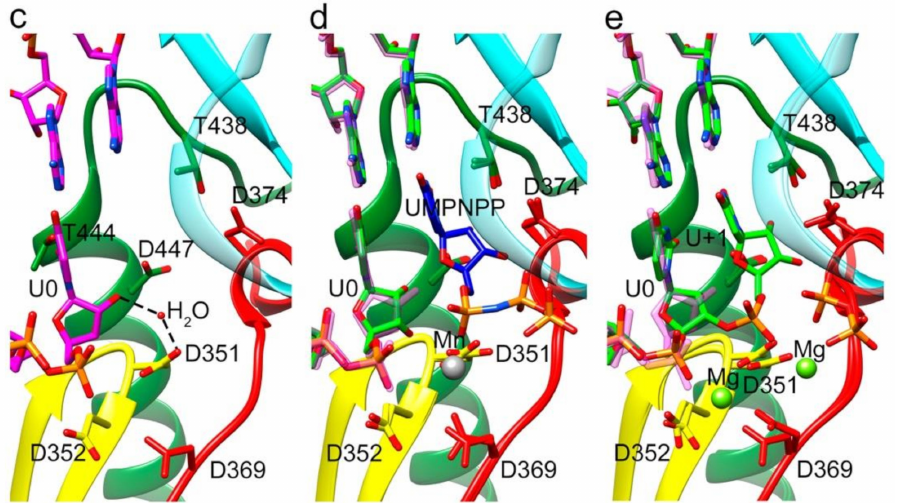
Figure 4. Overall structure of the TaV RdRP in complex with RNA and the incoming nucleoside analogue uridine-5’-[( α , β )-imido]triphosphate (UMPNPP). ( a ) Side view of the overall structure of the ∆ 10-TaV pol ∆ 607-624/5 (cid:48) CAAAAUUU3 (cid:48) /UMPNPP complex enzyme (grey) with the conserved motifs and the bound RNA template/primer colored as in Figure 1. The substrate analogue is shown as sticks, colored according to atom type (C blue). ( b ) Close up view of the interactions involved in substrate analogue recognition. The side chains of residues D374 (motif A) and T438 and D447 (motif B) that participate in UMPNPP 2 (cid:48) -OH recognition are shown as sticks and explicitly labeled. One Mn 2+ ion was found in the active site interacting with D351 (motif C), D369 (motif A) and the phosphate 1 moiety of the substrate. ( c ) Close up view of the active site region (same orientation as in B), in the structure of the TaV pol ∆ 607-624/5 (cid:48) CAAAAUUU3 (cid:48) complex obtained in the absence of incoming nucleotides. The polymerase molecule is shown as green ribbons with the key active site chain depicted as sticks. ( d ) Superimpositions of the TaV pol ∆ 607-624/5 (cid:48) CAAAAUUU3 (cid:48) complex structures in the absence (RNA carbon atoms in magenta) and in the presence of the UMPNPP analogue (RNA carbon atoms in green; UMPNPP in blue). The Mn 2+ ion is shown as a grey sphere. ( e ) Superimposition of the TaV pol ∆ 607-624/5 (cid:48) CAAAAUUU3 (cid:48) complex structures in the absence of the incoming substrate (RNA carbon atoms in magenta) and after UMP incorporation, trapped before translocation (RNA carbon atoms in green). The two bound Mg 2+ ions are shown as green